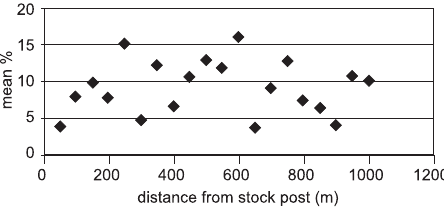
Fig. 2. Mean percentage deadwood cover on ground in relation to distance from stockpost ( n = 12